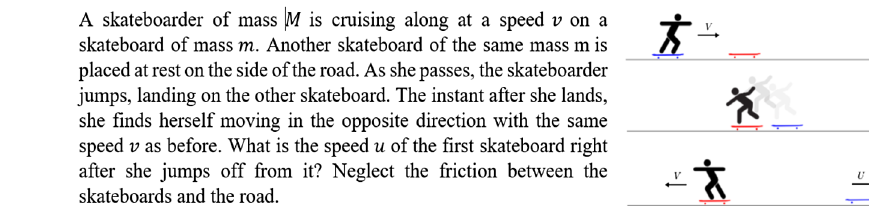
FIG. 10. Diagram and problem text for problem